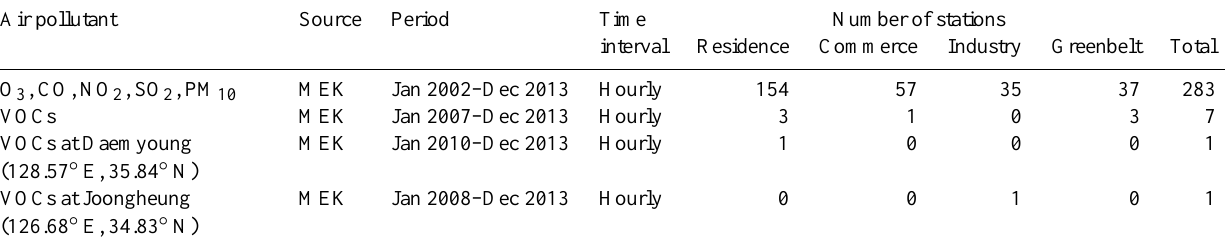
Table 2. Data information of the surface air pollutants (O 3 , CO, NO 2 , SO 2 , and PM 10 ) measured at 283 air pollution monitoring stations of the Ministry of Environment of Korea (MEK) in South Korea during 2002–2013. The information for the VOCs at nine of the photochemical MEK stations, simultaneously measured with the other pollutants at the same sites, has also been shown. The 9 out of the total of 19 VOC stations were selected in this study, based on their locations and their relatively long-term records since 2007. Air pollutant Source Period Time Number of stations interval Residence Commerce Industry Greenbelt Total O 3 , CO, NO 2 , SO 2 , PM 10 MEK Jan 2002–Dec 2013 Hourly 154 57 VOCs MEK